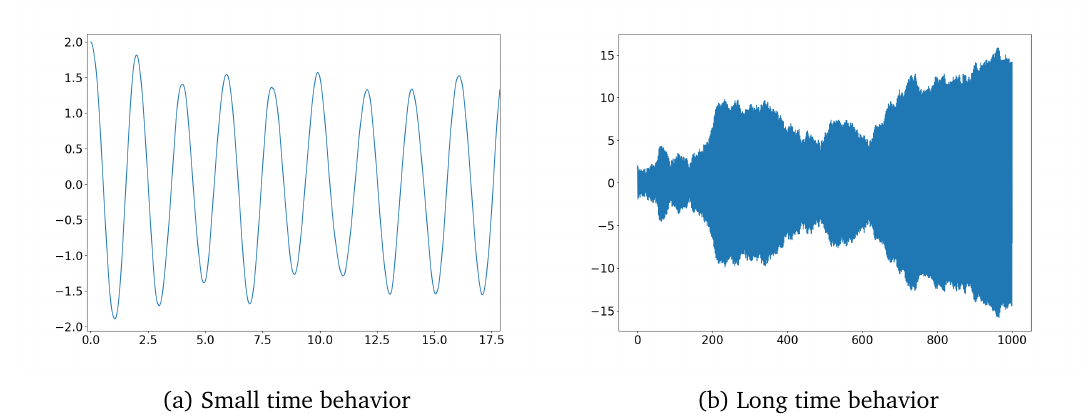
Figure 1: Typical behaviors of a particle trapped in an harmonic oscillator in the strong monitoring regime. The plots correspond to the evolution of the position of the particle viewed at different time scales and evolving according to (25,26) with Ω = 1, ε = 1, x = 2, v = 0. We clearly have a transition from an oscillatory 0 0 behavior at time of order 1 / Ω to a diffusive regime for t (cid:29) 1 / Ω